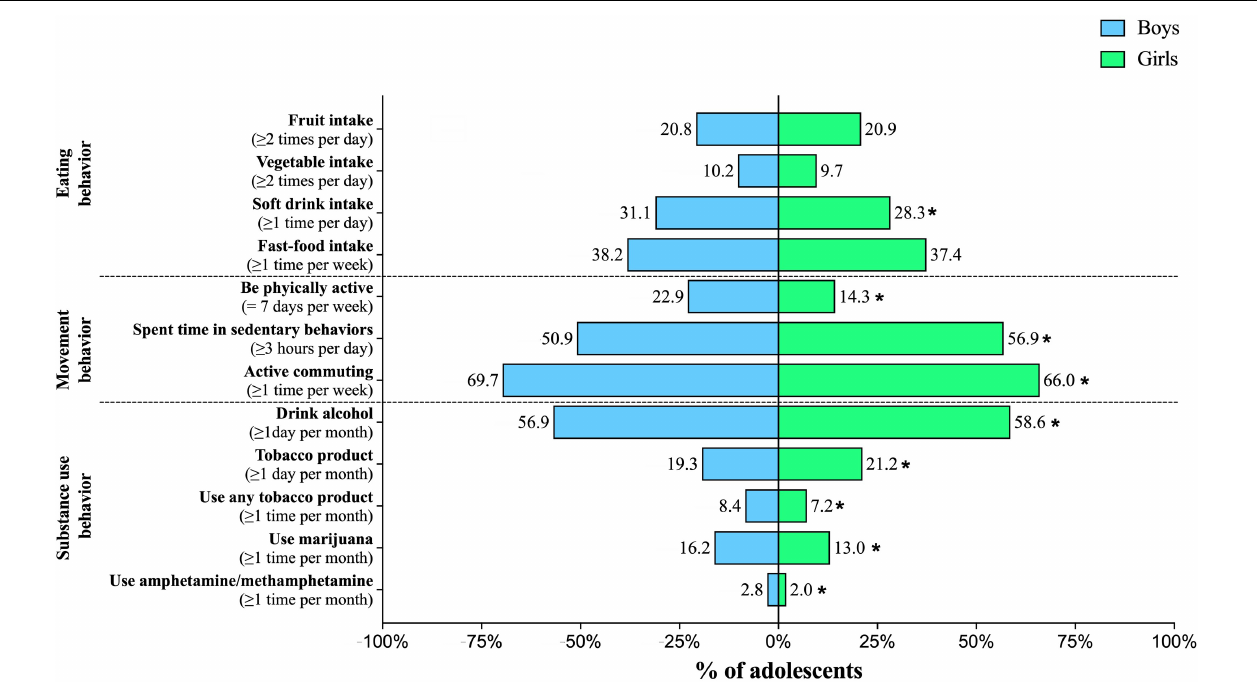
FIGURE 1 | Prevalence of different lifestyle behaviors stratified by